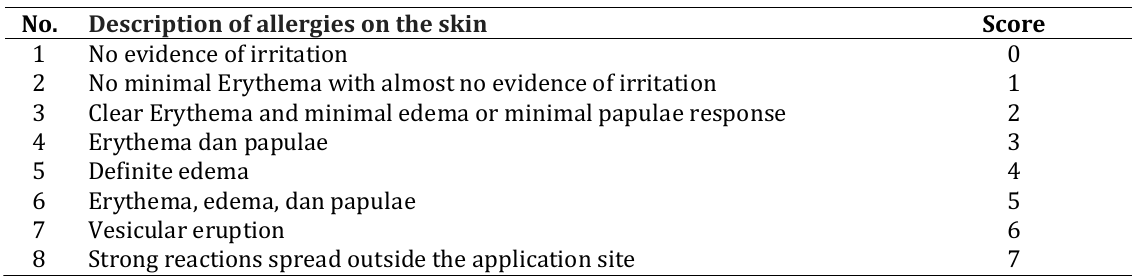
Table II. Scoring events Incidence of hand antiseptic allergy on the skin of the hands (FDA, 2018).